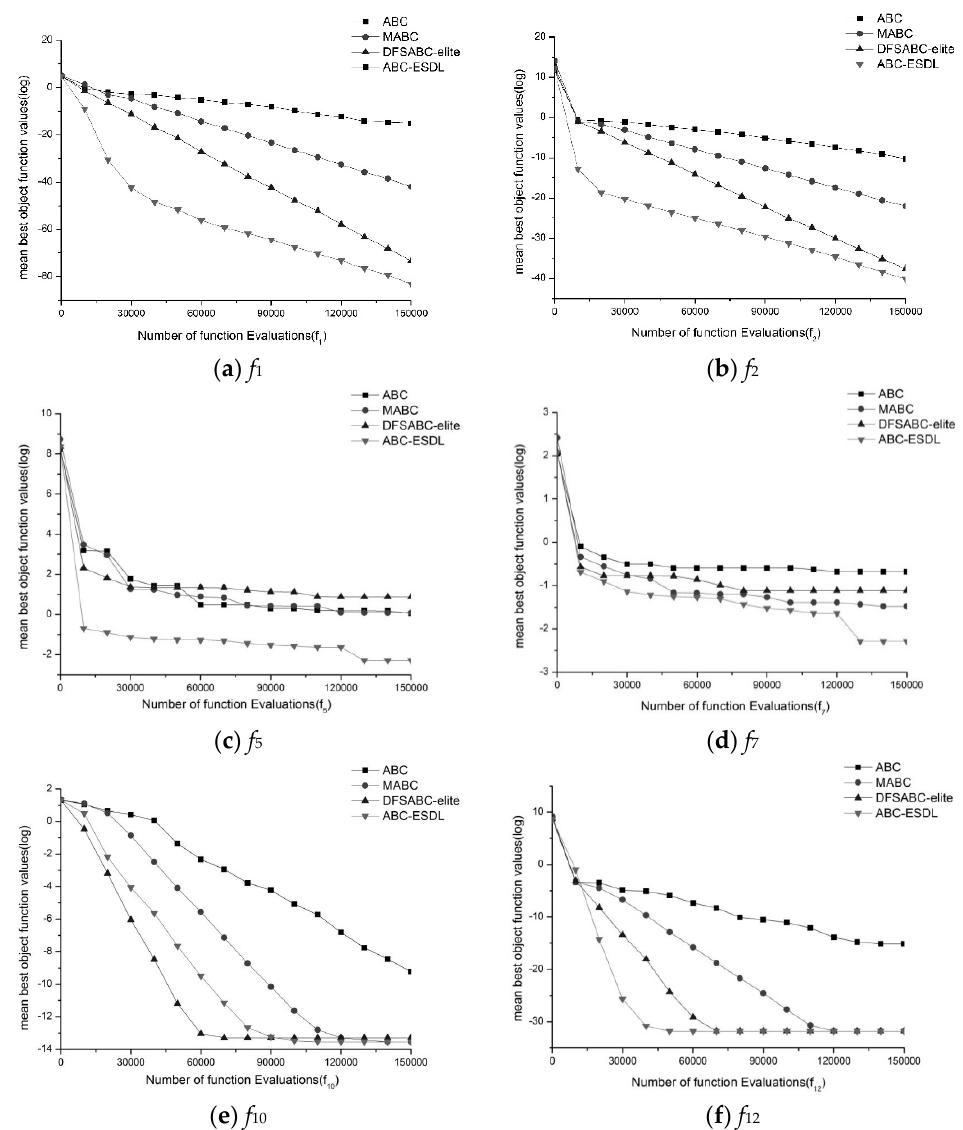
Figure 2. The convergence curves of ABC-ESDL, DFSABC-elite, MABC, and ABC on selected functions. ( a ) Sphere; ( b ) Schwefel 2.22; ( c ) Rosenbrock; ( d ) Quartic; ( e ) Ackley; and ( f ) Penalized.